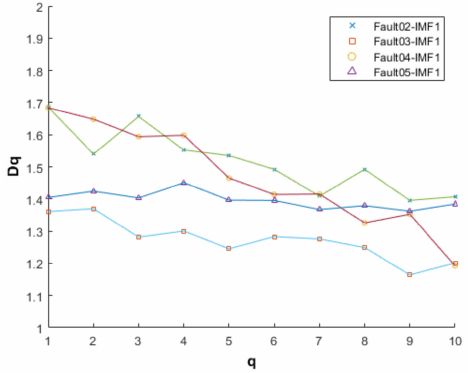
Figure 11. IMF1‑EMD box fractal dimension map.